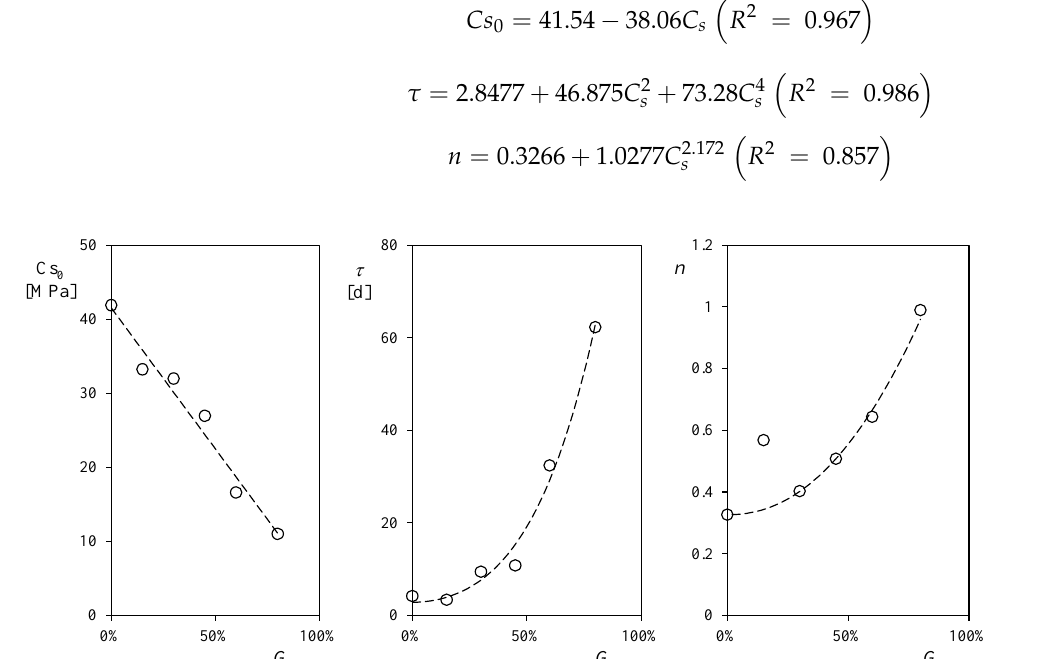
Figure 6. Coefficients of Equation (1), Cs 0 , τ , and n , plotted in relation to the amount of glass powder used to replace the cement, Gp . The corresponding lines of tendency (Equations (3)–(5)) have been plotted as dashed lines.